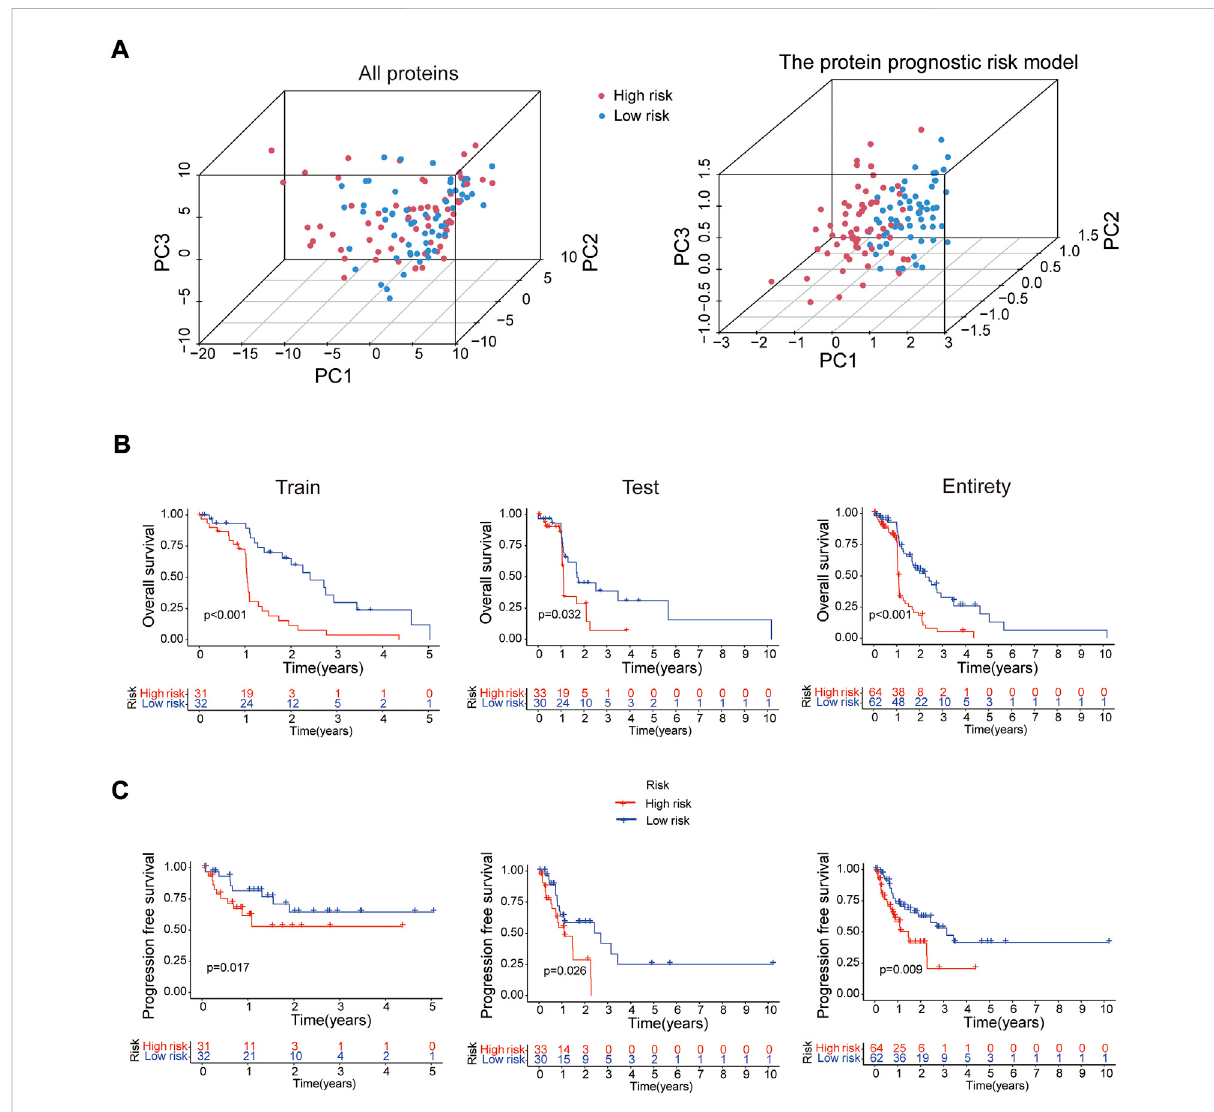
FIGURE 3 Survival analysis of the risk model. (A) PCA analysis for whole protein expression pro fi le and the risk model. The overall survival (B) and progression free survival (C) analyses between the high- and low-risk groups in the train ( n = 63), test ( n = 63) and entire ( n = 126)